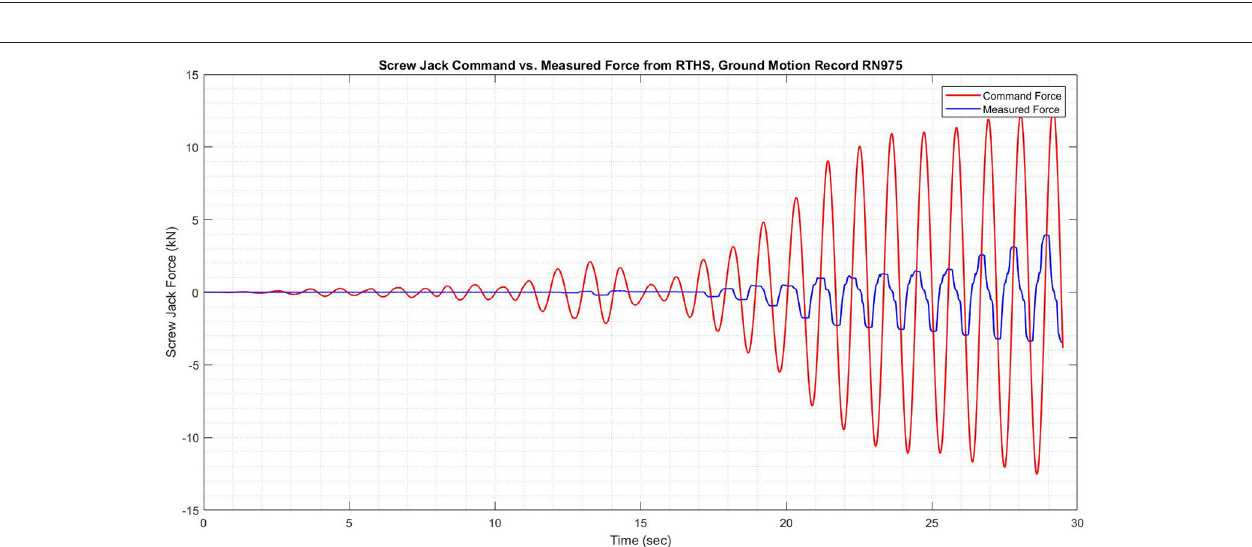
FIGURE 12 | Results of LSM showing structural displacement with and without screw jack for record 3,202.